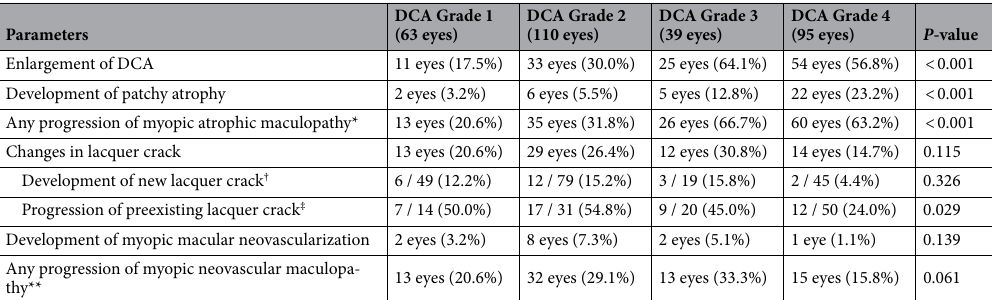
Table 2. Progression pattern according to the baseline grade of diffuse chorioretinal atrophy. DCA = Diffuse chorioretinal atrophy. *Includes enlargement of DCA and development of patchy atrophy lesion. † In eyes without lacquer crack at baseline. ‡ In eyes with preexisting lacquer crack at baseline. **Includes changes in lacquer crack and development of myopic macular